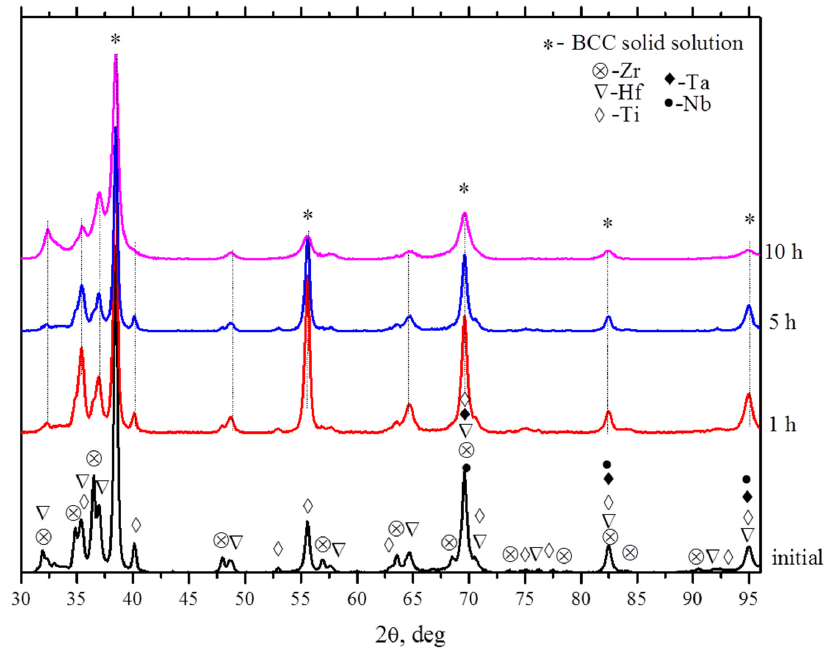
Figure 5. XRD patterns of HfTaTiNbZr powder mixtures taken after low-energy ball milling (LEBM) for di ff erent t (indicated on the right).